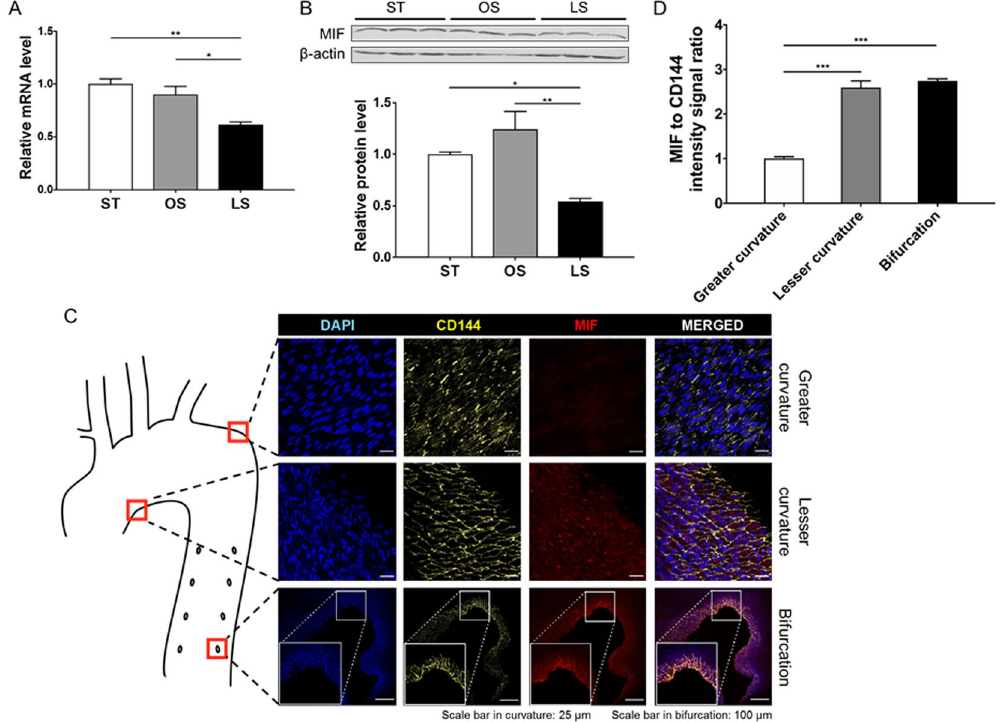
Figure 2. MIF expression in ECs is regulated by shear stress. The transcript level of MIF detected by qPCR ( A ) in human coronary artery endothelial cells (HCAECs) after 24-hour exposure to static (ST) culture, oscillatory shear stress (OS) and laminar shear stress (LS) (n = 4). Representative immunoblot (top) band intensity quantification (bottom) ( B ) of intracellular MIF protein levels in human umbilical endothelial cells (HUVECs) after 24-hour exposure to ST, OS and LS (n = 3). In all bar graphs, data are shown as mean ± SEM. * P < 0.05, ** P < 0.01. ( C ) En face immunostaining with anti-CD144 (vascular endothelial cadherin, yellow) and anti-MIF (red) and counterstaining with DAPI (nuclear, blue) to show relative MIF protein abundance in the different parts of the rabbit aorta (location is shown in the Cartoon). MIF is highly expressed in lesser curvature as well as bifurcation areas. Data are representative of four independent experiments. Scale bar in upper 2 panels: 25 μ m; Scale bar in the bottom panel: 100 μ m. ( D ) Quantification of the data using Image J shows MIF intensity ( *** P < 0.001 vs greater curvature; n =